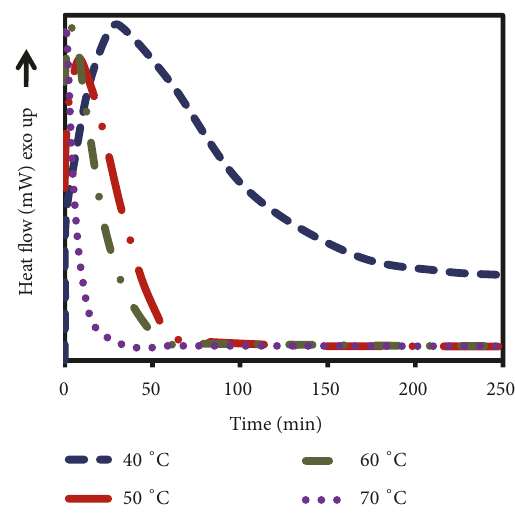
Figure 2: Calorimetric traces associated with curing of epoxy at different isothermal